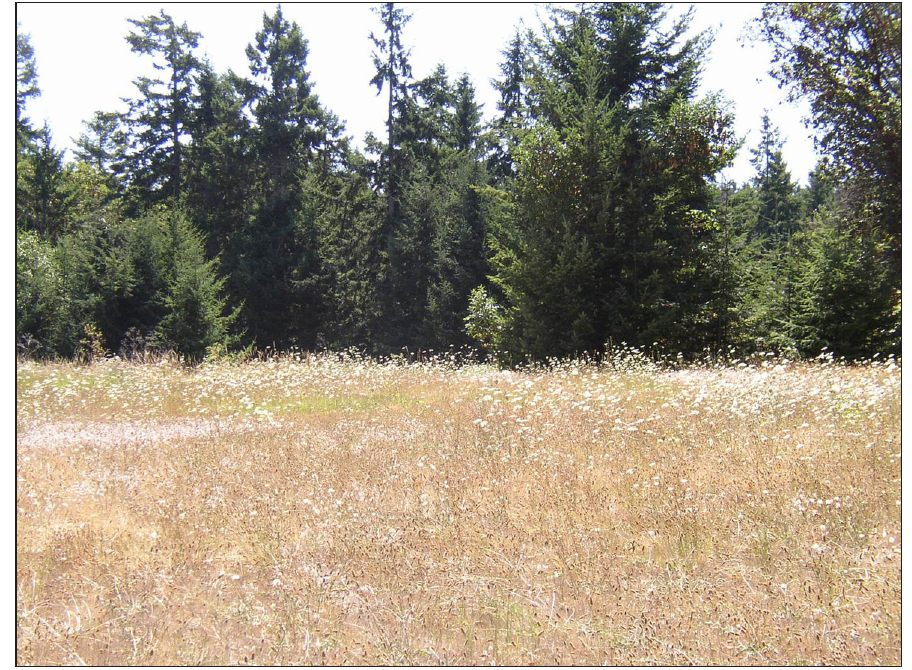
Figure 2: A field in the Dungeness Valley, Clallam County, Washington inundated with wild carrot. Prevention, eradica- tion, or even widespread control of the weed are not feasible options under these conditions. Photo by the